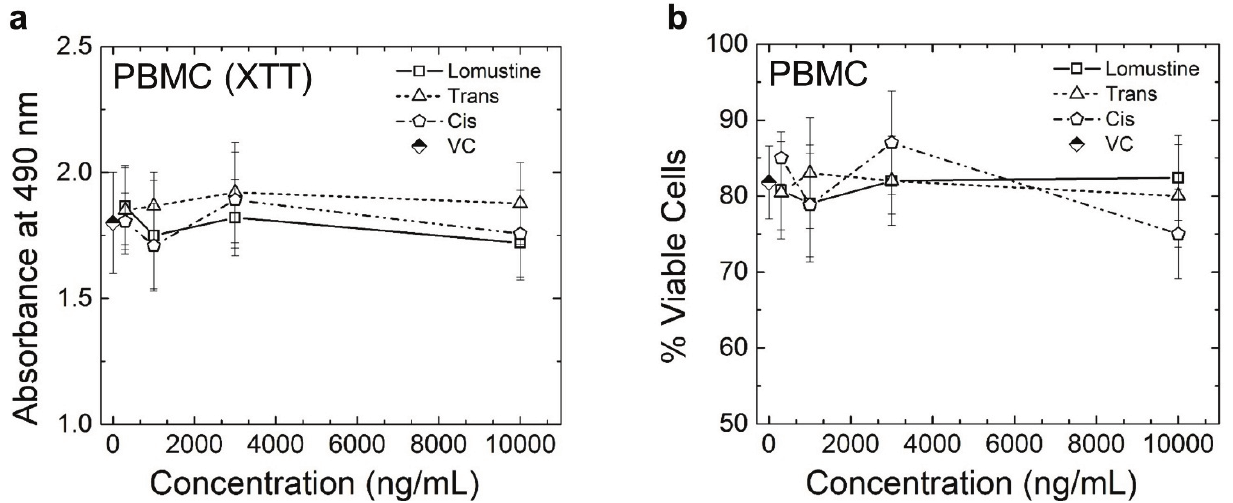
Figure 5. Graphs showing the results of XTT assay ( a ) and Annexin/PI assay ( b ) in peripheral blood mononuclear cells (PBMC) isolated from three lymphoma dogs. Vehicle control (VC) was 0.1% methanol. The graph shows the mean and standard deviation of results obtained from three dogs. No statistically significant difference was seen in any of the drug treated samples compared to VC.